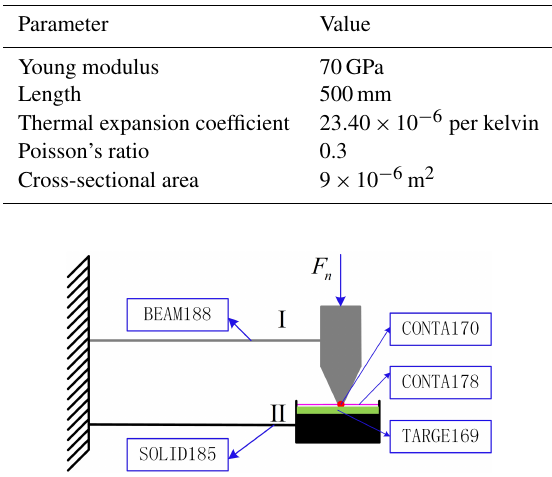
Figure 6. Schematic diagram of finite element model.